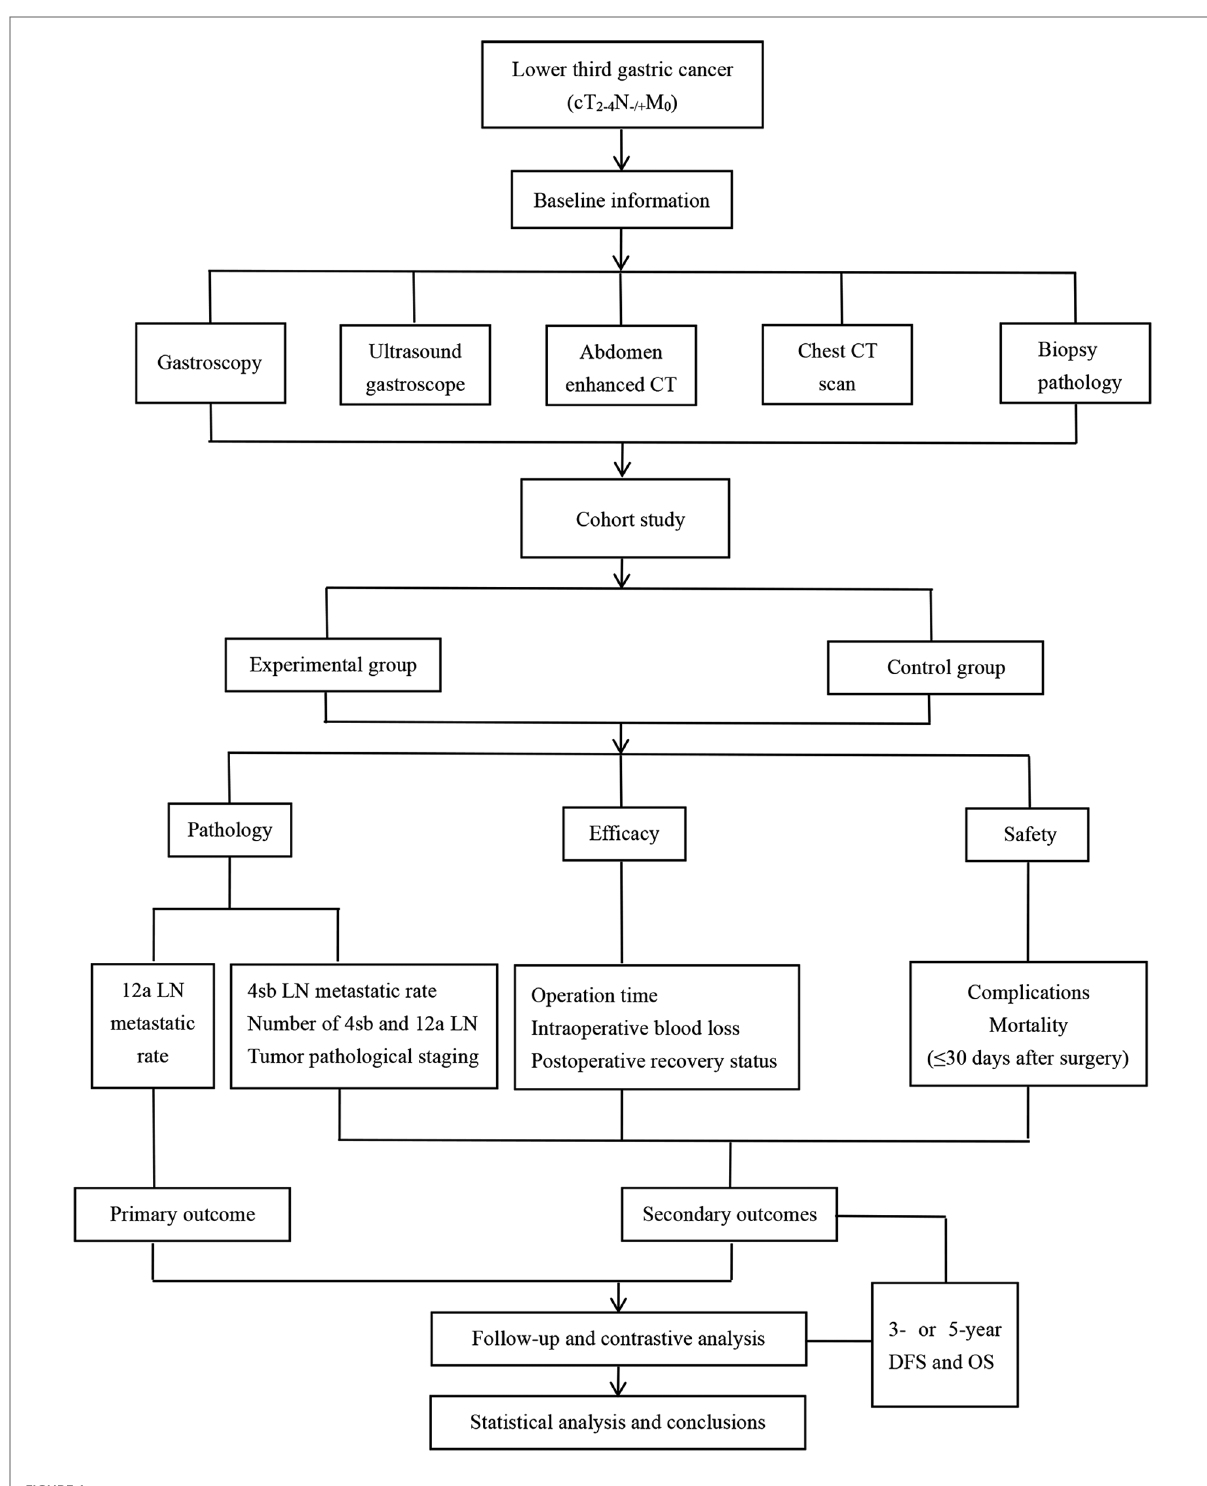
FIGURE 1 Research process and fl ow chart. LN, lymph